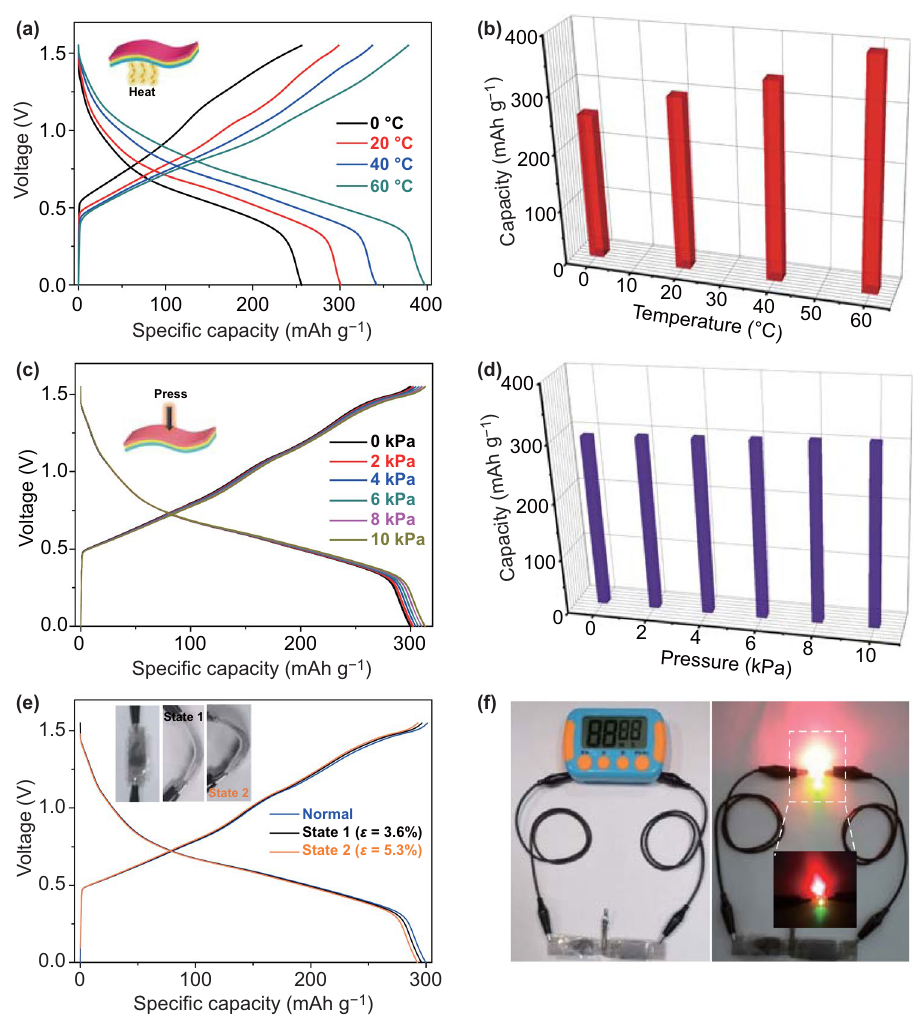
Fig. 6 Quasi-solid-state Zn//KVO cell. a GCD curves at different temperatures and b plot of discharge capacity versus temperature. c GCD curves under different pressures and d plot of discharge capacity versus mechanical pressure. e GCD curves under different bending conditions (inset is the optical images of the device at the normal and 2 bendable states). f Optical images of a digital timer and three LED indicators light- ened by the